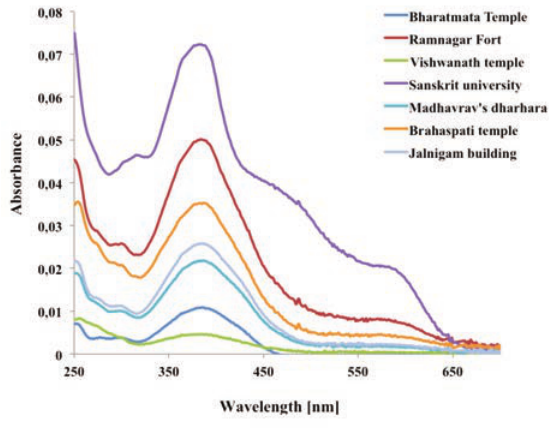
Figure 5. Absorption Spectra of scytonemin extracted from cyanobacterial samples collected from different historical mon- uments of Varanasi, India. All the experiments were repeated thrice with at least three replicates.